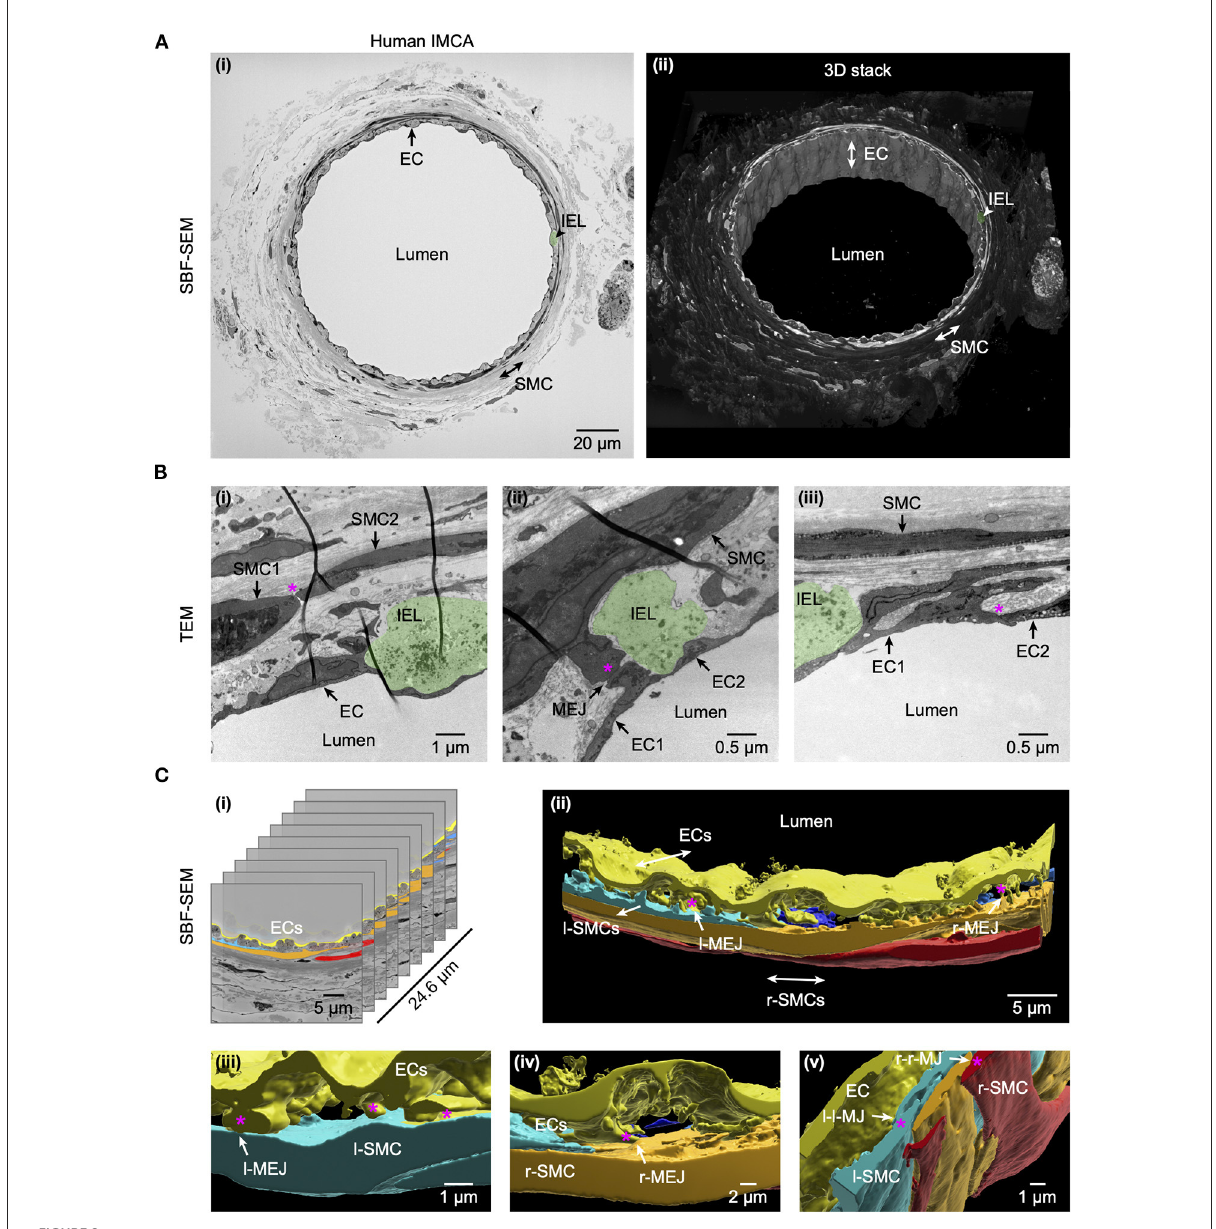
FIGURE2 Cell-cell contact sites in a human RA-IMCA with good contractile function. The artery (Artery #1, Table 2) was first used for functional experiments (included in Figures 3, 7) and then while still cannulated and pressurized, processed for both serial block face scanning electron microscopy (SBF-SEM, A ) and transmission electron microscopy (TEM, B ). At low resolution (A) it is clear that 1–2 layers of SMCs surround the ECs and internal elastic lamina (IEL). Arrows indicate the same EC, and position of SMCs and IEL in both the 2D- (left) and 3D- (right) images. The IEL comprises longitudinal strings of elastin (examples in Figures 5A, 6A,B), one example is highlighted in green in all panels. A movie through the 3D z-stack at low and higher resolution is available at Dora et al. (18). Higher resolution images (B) were obtained before processing for SEM, and showed clear contact sites between SMCs, between SMC and ECs, and between ECs, an example indicated by the asterisk in each panel. Representative of 5 arteries which developed myogenic tone and responded to BK (18). (C) The cell-cell contact sites were also visible in the SBF-SEM images (Supplementary Video 1). Individual cells were 3D rendered and are shown superimposed on the original images (i) and as the reconstructed artery walls (ii–v) . Longitudinally arranged SMCs (l-SMCs) are shown in blue (see Figure 12), and circumferential radial SMCs (r-SMCs) in orange and red; each of which contacted each other and endothelial cells. Examples are indicated by r-MEJ, r-SMC to EC junction; l-MEJ, l-SMC to EC junction; l-l-MJ, l-SMC to l-SMC junction; r-r-MJ, r-SMC to r-SMC